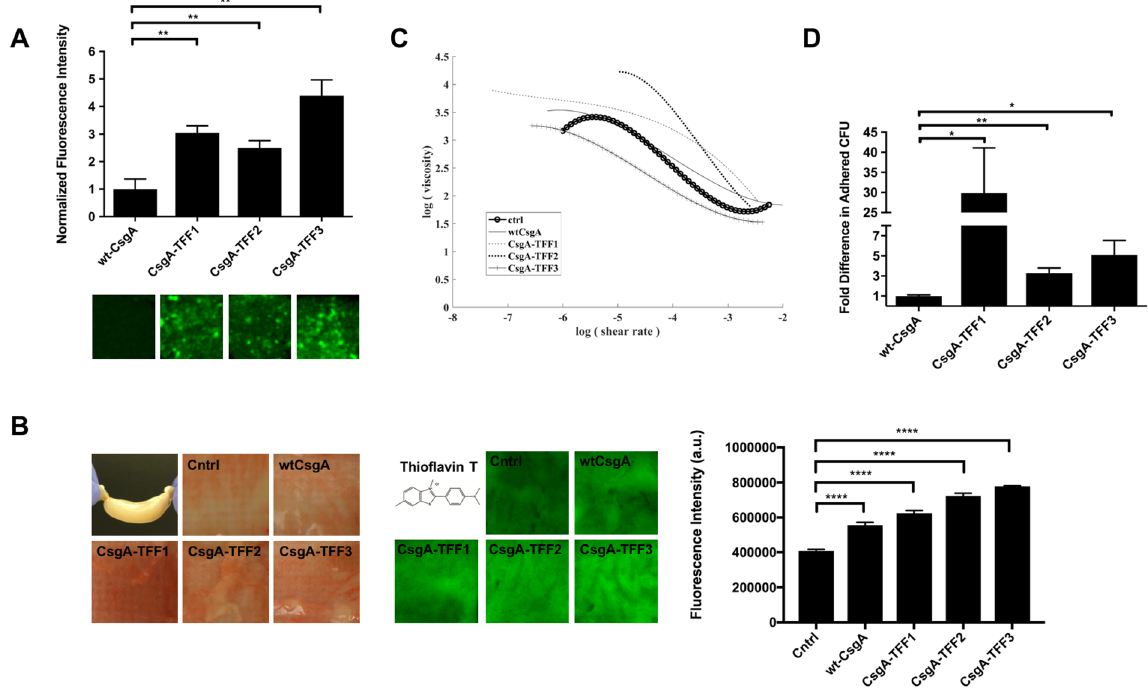
Figure 3. Engineered curli matrix enhances E. coli adhesion to gut mucosa. ( A ) Anti-Muc-2 detection of mucins after incubation on top of filtered biofilms producing curli-TFF fusions, ( B ) Congo Red and Thioflavin T staining of goat colon after incubation with engineered curliated E. coli variants. ( C ) Viscosity vs. shear rate analysis for mucins combined with curliated bacterial cultures. Ctrl indicates cells containing a plasmid with no CsgA encoding gene. ( D ) Bacterial adhesion to Caco-2 cell monolayers. Ordinary one way ANOVA with Dunnett’s multiple comparison test n = 10, * P < 0.05, ** P < 0.01, *** P < 0.001, **** P <